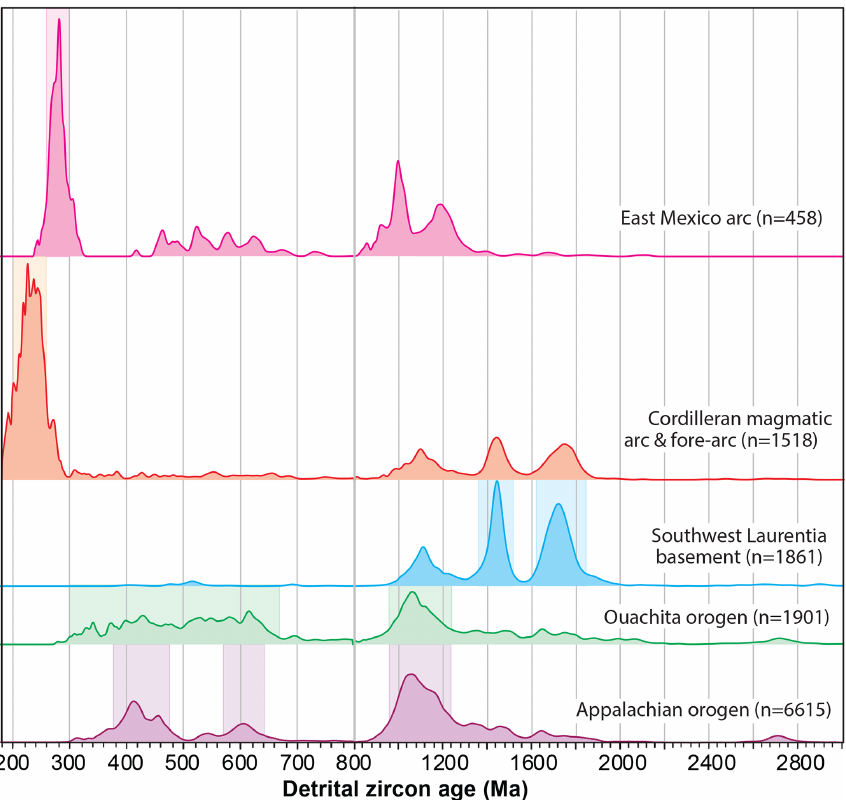
Figure 3. Normalized probability density plots of U–Pb (zircon) ages from source terranes. Distinctive age groups include 1750–1620 and 1520–1360Ma ages from southwest Laurentia basement provinces, 1240–960Ma ages from Grenville-age provinces exposed in the Appalachian and Ouachita orogens, 640–570 and 480–370Ma ages characteristic of the Appalachian orogen, 670–300Ma ages from the Ouachita orogen, 300–260Ma ages from the East Mexico arc, and 260–200Ma ages belonging to the Cordilleran magmatic arc of south- western North America. See text for sources of